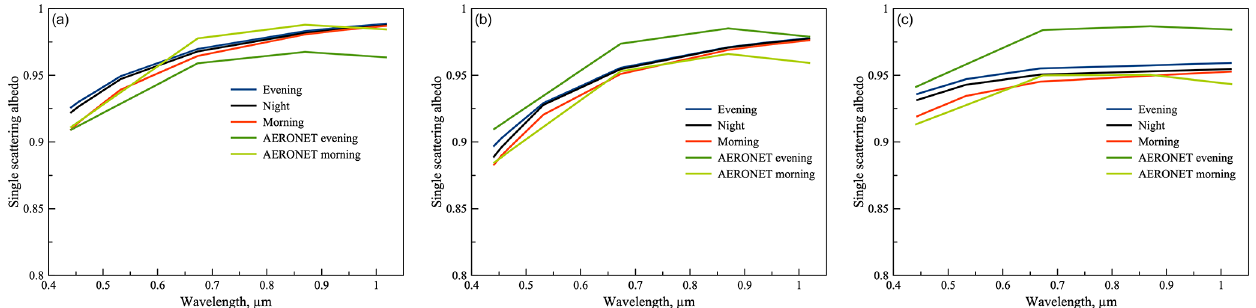
Figure 8. Aerosol single scattering albedo retrieved during the COBALD radiosonde flight on 5 August 2015 (a) , 11 August 2015 (b) and 12 August 2016 (c) . Values retrieved before and after the radiosonde flight with the use of combined Sun-photometer and MPL data are shown in blue and red, and those retrieved by AERONET are in dark and light green, respectively.